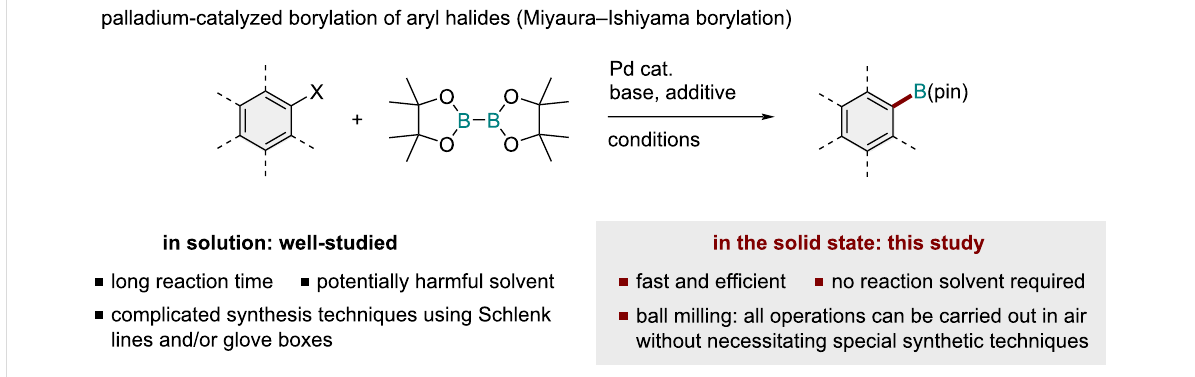
Scheme 1: Development of the first solid-state palladium-catalyzed borylation protocol of aryl halides using